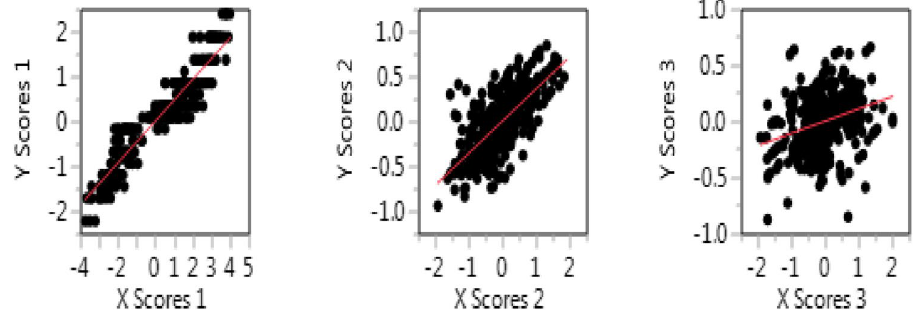
Fig. 25 Scores plots for ROP model